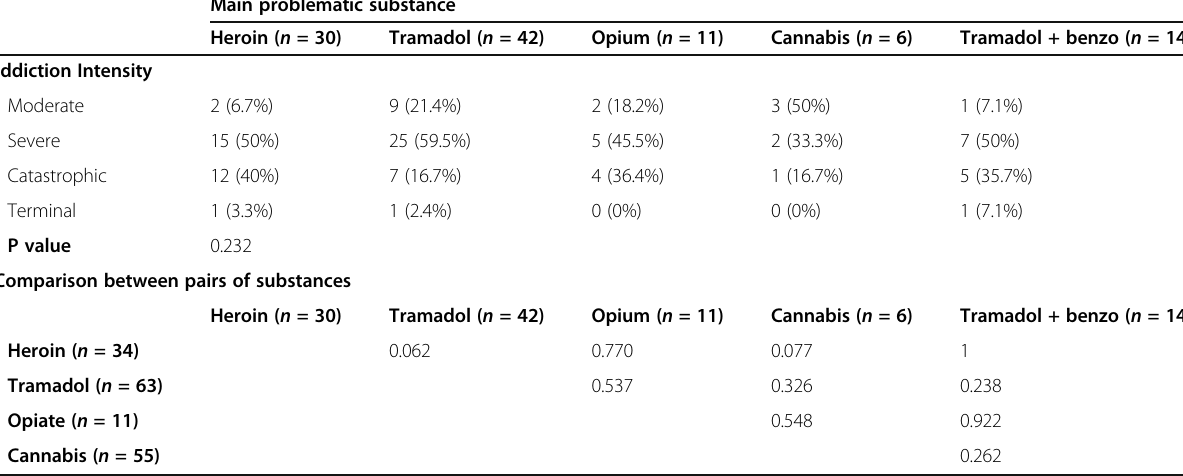
Table 4 Comparison between scoring of Addiction Intensity Scale in patients with different main problematic substance